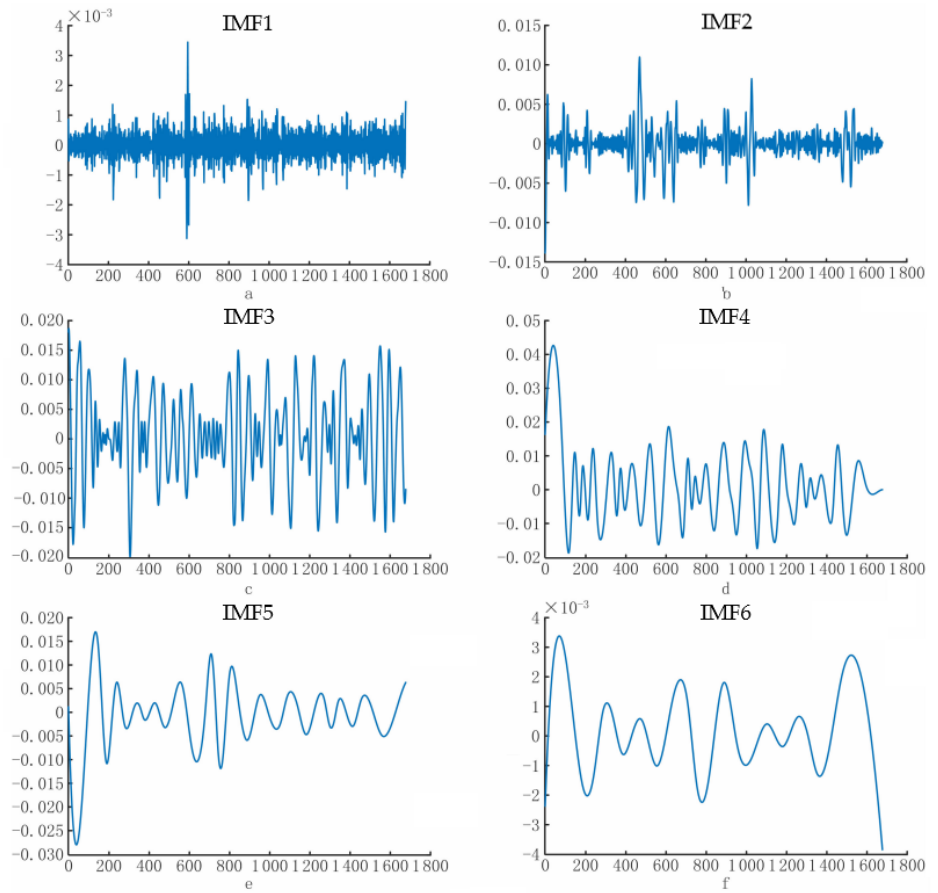
Figure 8. IMF image after EEMD decomposition of normal data. ( a ) IMF1 component after EEMD decomposition of normal data; ( b ) IMF2 component after EEMD decomposition of normal data; ( c ) IMF3 component after EEMD decomposition of normal data; ( d ) IMF4 component after EEMD decomposition of normal data; ( e ) IMF5 component after EEMD decomposition of normal data; and ( f ) IMF6 component (residual component) after EEMD decomposition of normal